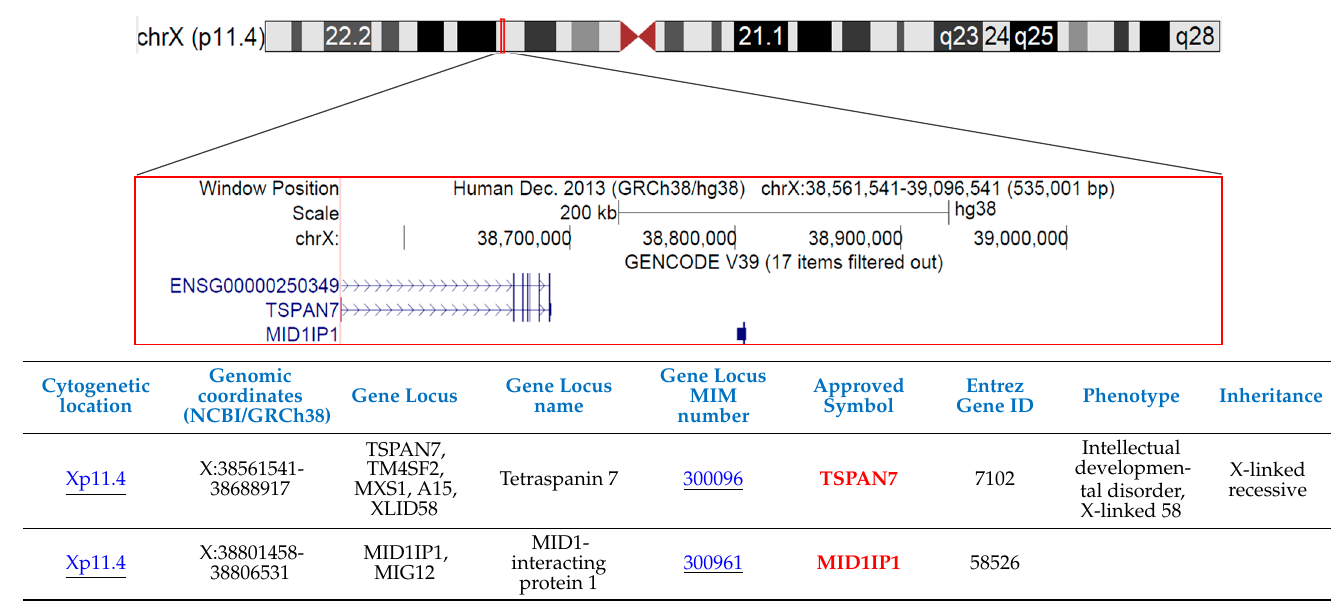
(Table 2). The microduplication was probably inherited from the father, because the younger sister, apparently healthy, was also a carrier of this microduplication. Table 2. Online Mendelian Inheritance in Man (OMIM®)–Gene–Map–List on chromosome–X Table 2. Online Mendelian Inheritance in Man (OMIM ® )–Gene–Map–List on chromosome–X.